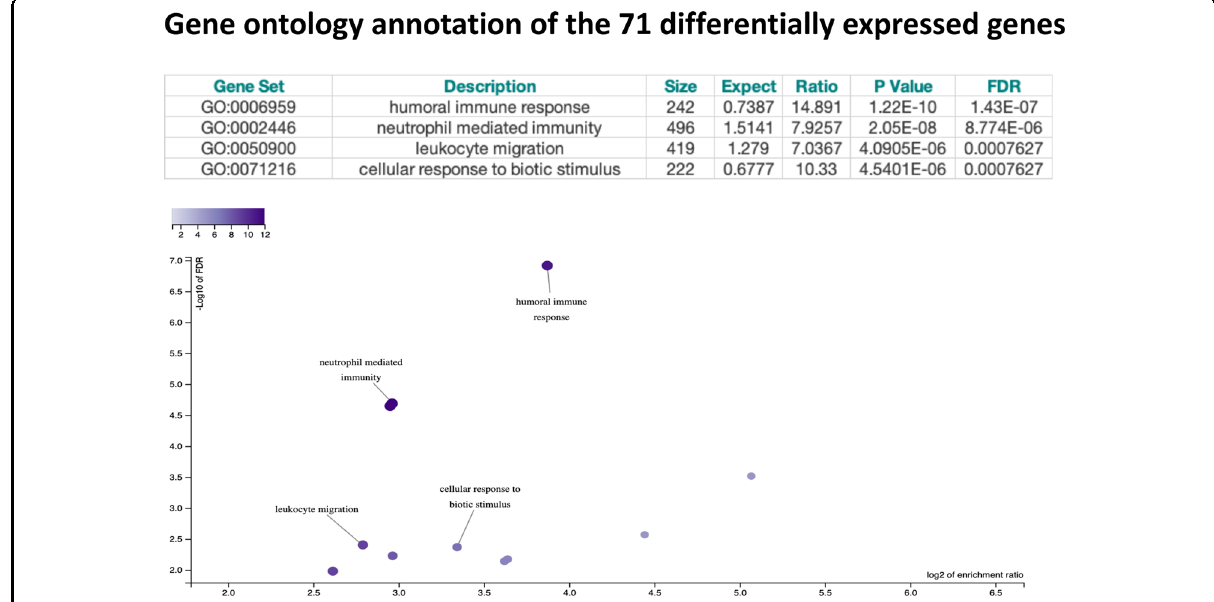
Fig. 2 Functional annotation. Functional annotation of the differentially expressed genes associated with depressive symptoms at 2 months